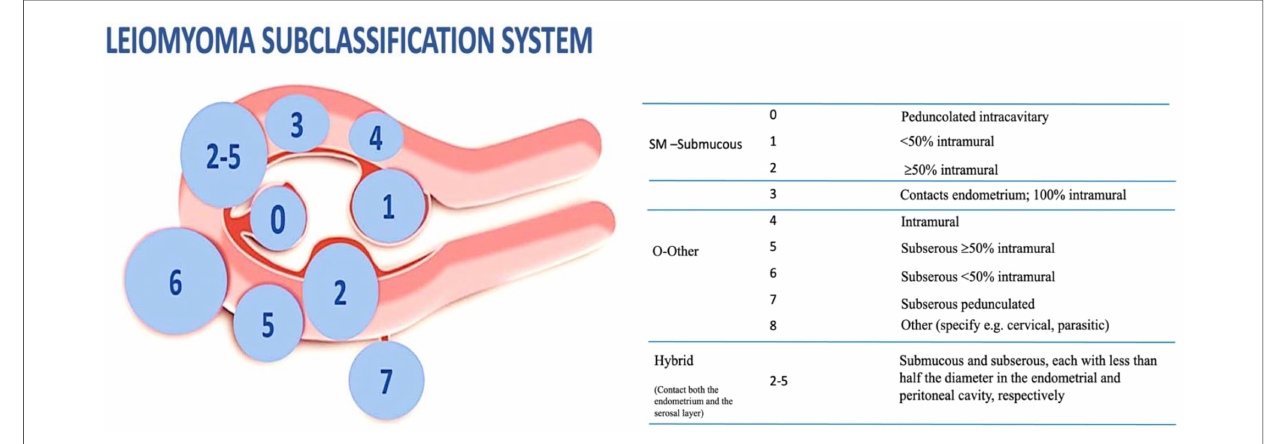
FIGURE 2 FIGO classi fi cation of uterine fi broids according to Munro et al.